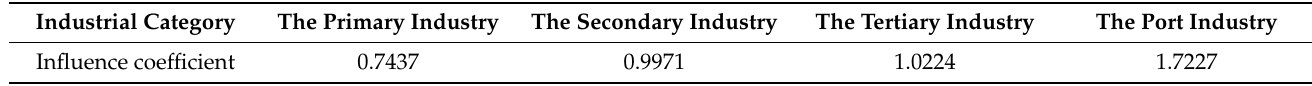
Table 3. The influence coefficients of Xiamen Port industry and three major industries in